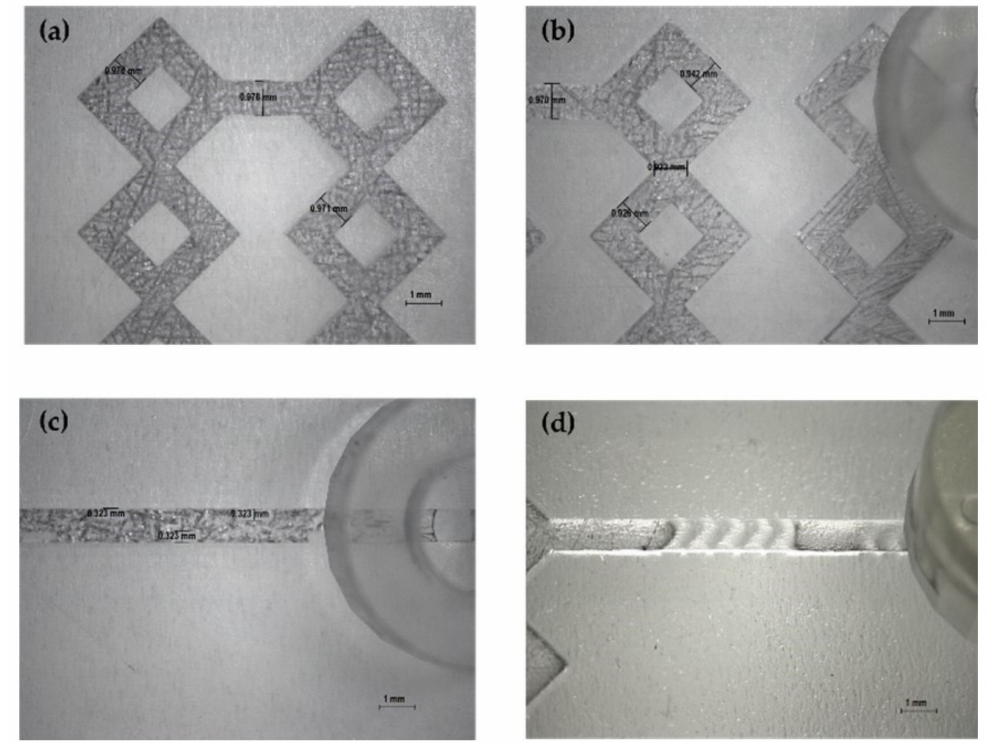
Figure 5. Optical microscope images of DLP 3DP devices (8 × ). ( a , b ) Image of the microchannels of devices. ( c ) Image of wedges (device 3). ( d ) Image of the modified herringbone structure (device